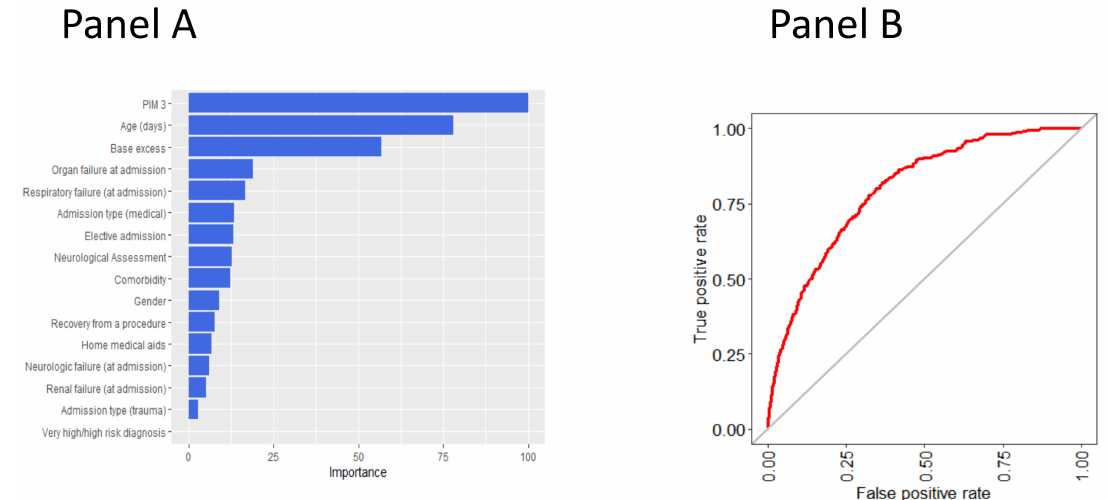
Figure 2. Random forest’s variable importance plot (Panel A ) and ROC curve on the random forest predictions (Panel B